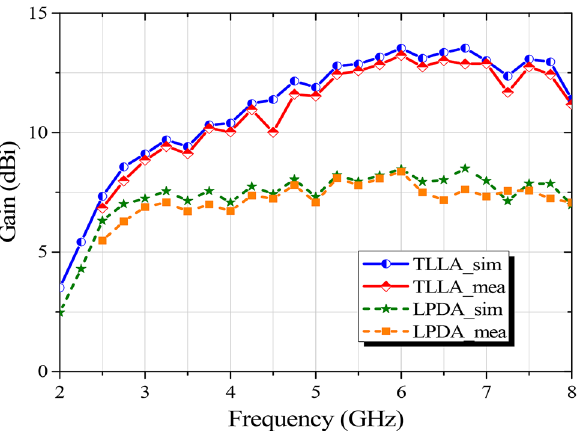
Figure 13. Comparison of the simulated and measured gains versus frequency when the proposed metalens serves as a Luneburg